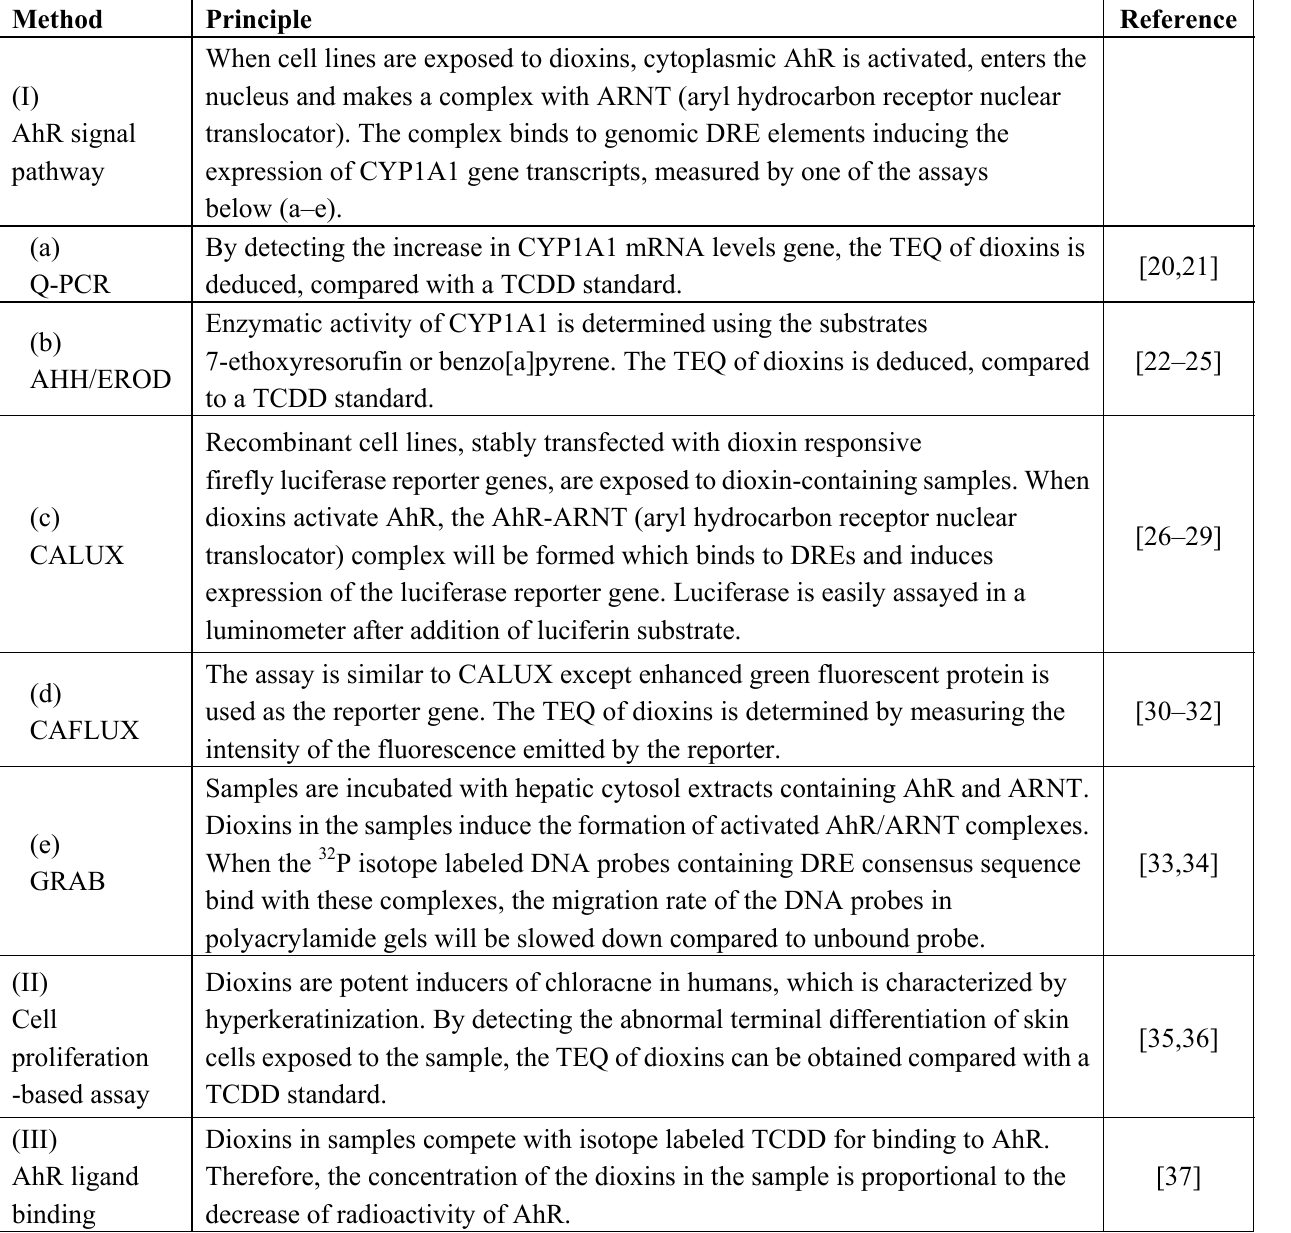
Table 1. Principle of biological detection methods for